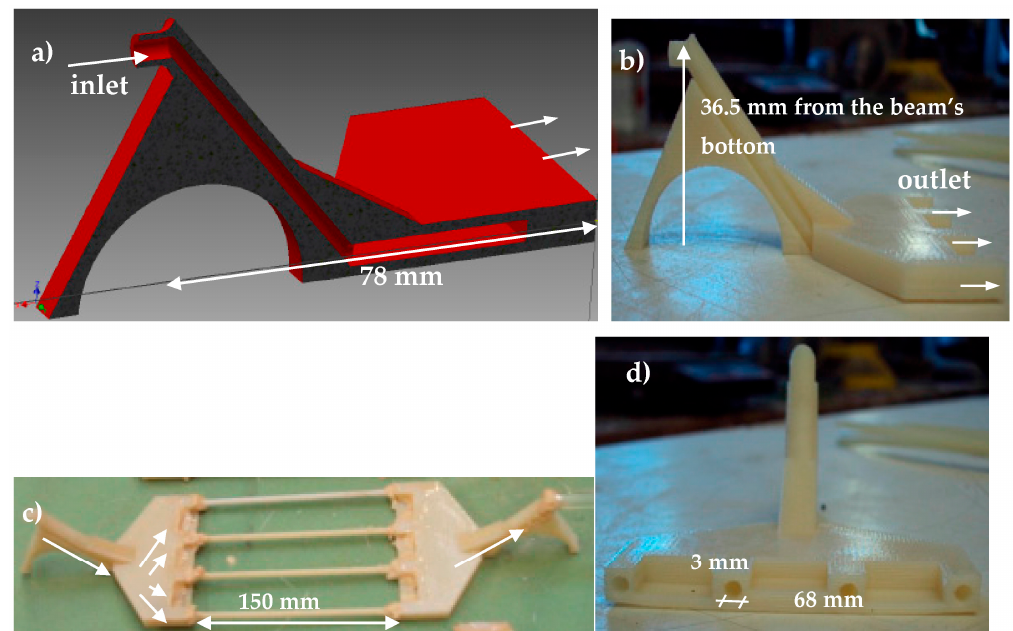
Figure 18. ( a ) Cross section of the 3D printed distribution piece (computer model); ( b ) side view of the printed piece; ( c ) printed pieces connected to 4 cementitious tubes; and ( d ) front view of the printed piece.